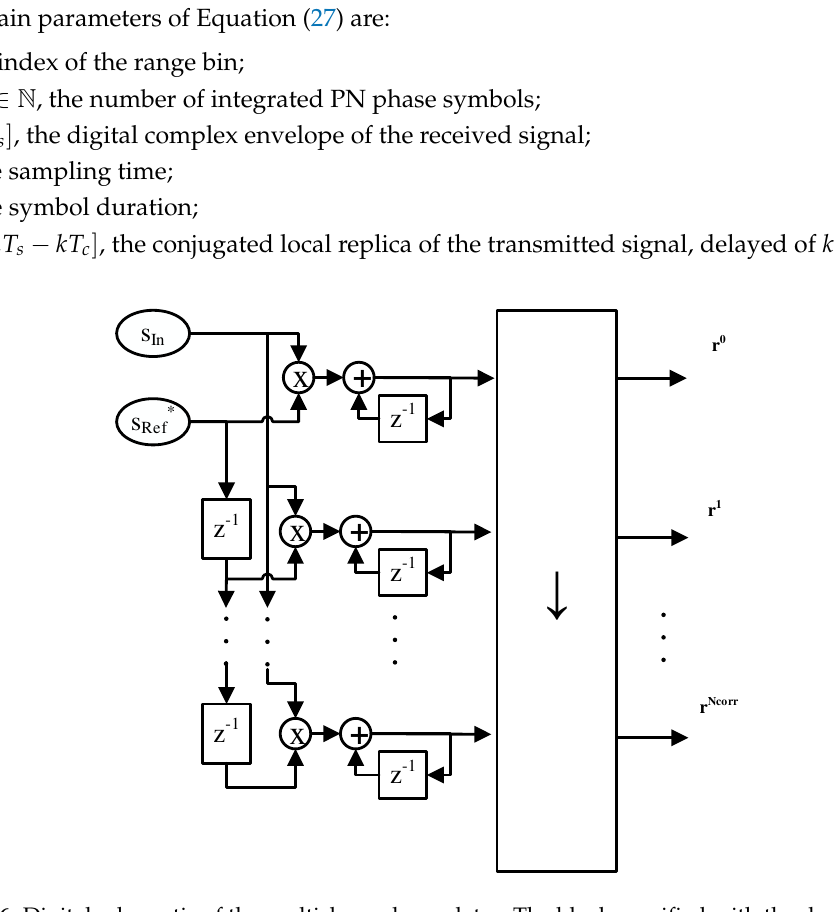
Figure 6. Digital schematic of the multichannel correlator. The block specified with the down-arrow represents the dump function which samples the resulting signals after the integration time, T . Both the multiplications and the summations must be considered as complex operations because they work with complex